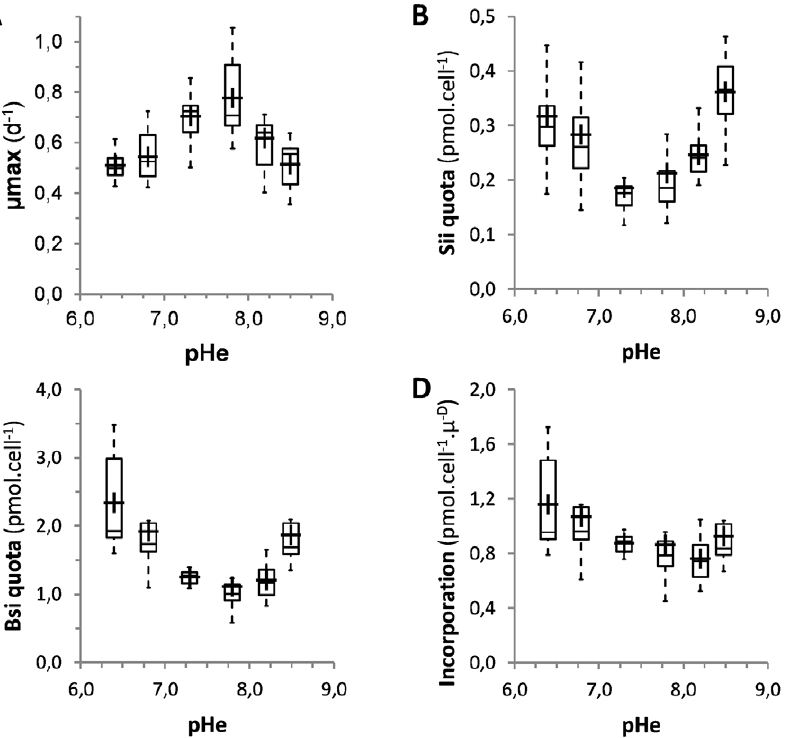
Figure 1. Influence of the external pH on cell growth and silicon metabolism in T.weissflogii . ( A ) Variations of the maximal growth rate ( m max) at different environmental pH values. Boxplots correspond to 5 to 11 independent experiments. The highest growth rate at pH=7.8 was confirmed in individual experiments, but was only significant as compared to pH=6.4, 6.8 and 8.5 ( p # 0.007). ( B ) Intracellular silicic acid (Sii) content per cell was determined from cells grown in artificial sea medium adjusted to different pH values. ( C ) Frustule-bound BSi content per cell. Boxpolts in B and C correspond to 4 to 10 independent experiments, with duplicate measurements for each experiment. ( D ) Boxplot illustrating the silicon incorporation rate, i.e. , the rate of frustule formation (pmol cell 2 1 m 2 D ) as a function of environmental pH. For explanations about boxplot representation, see METHODS.